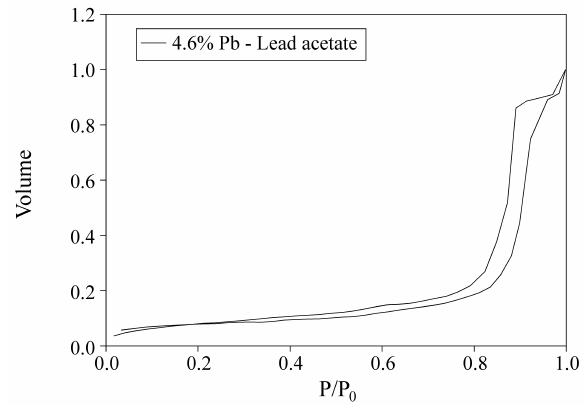
Figure 4. Sorption-desorption isotherm of gel obtained via lead acetate, heat treated at 900 °C (the weight of the sample was not considered, then volume scale is relative).